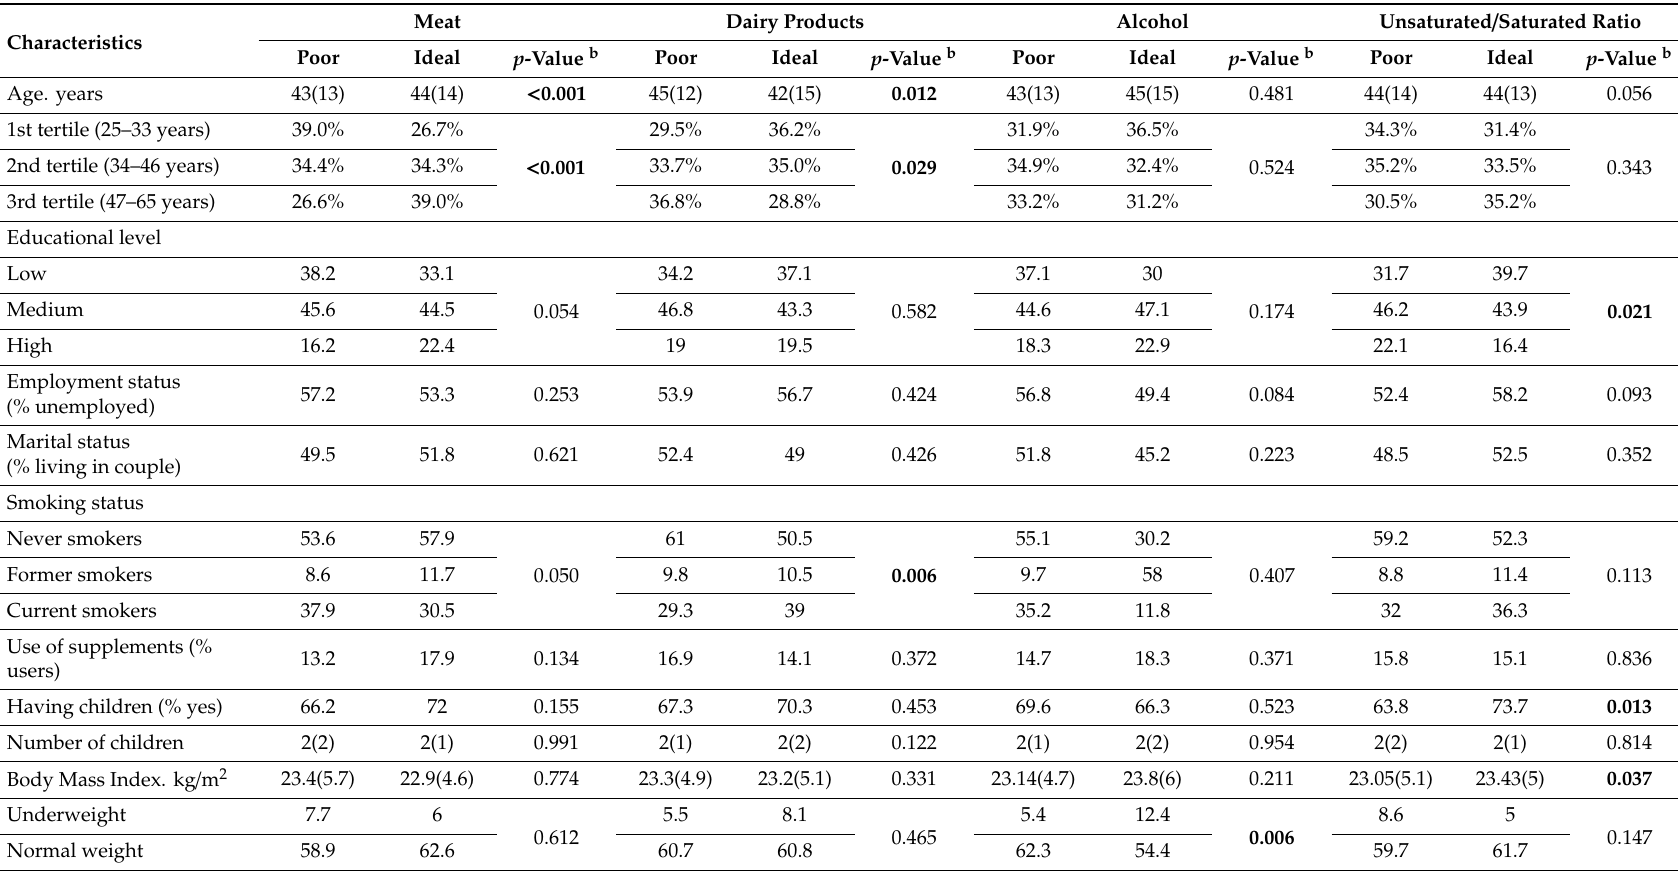
Table 2. Characteristics of women according to consumption of meat, dairy products, alcohol, and lipids a